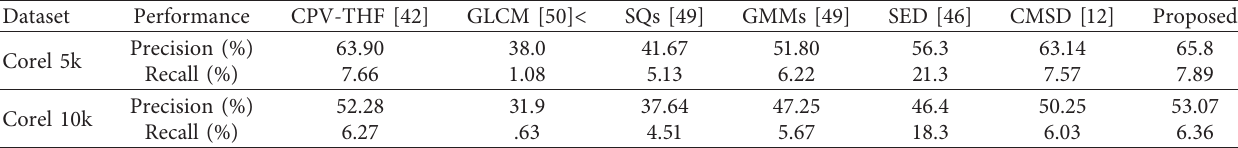
Table 11: Performance of NRLGO is compared with uniform pattern-based state-of-the-art methods on Corel dataset with 5000 images and Corel dataset with 10000 images.